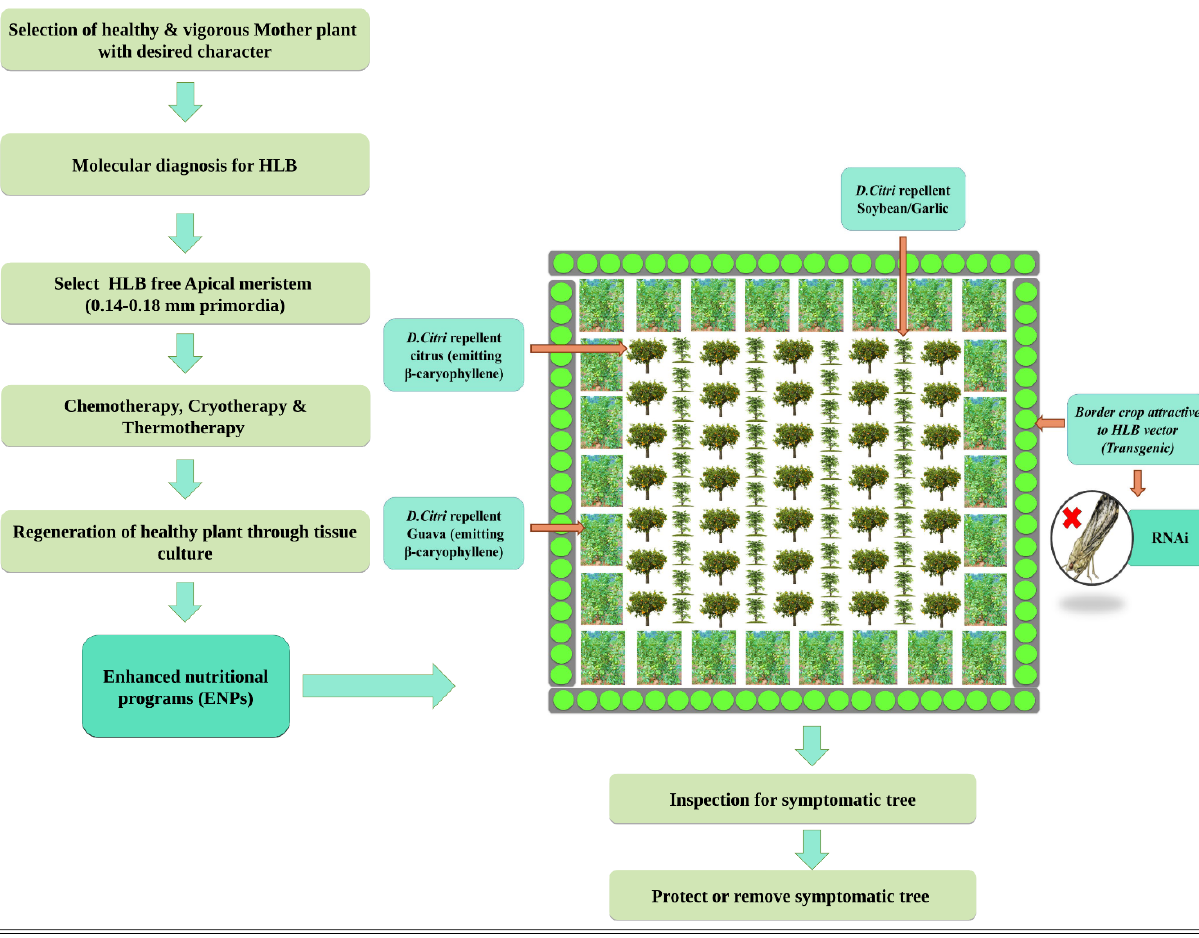
Figure 14. Overall preventive measures to establish HLB-free citrus orchards.